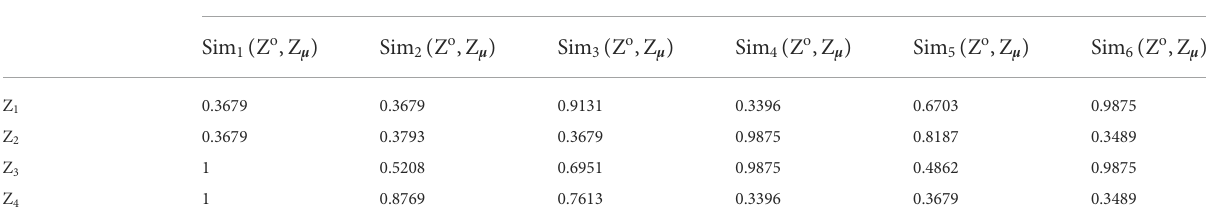
TABLE 14 Computation results of Sim a ( Z o , Z μ )